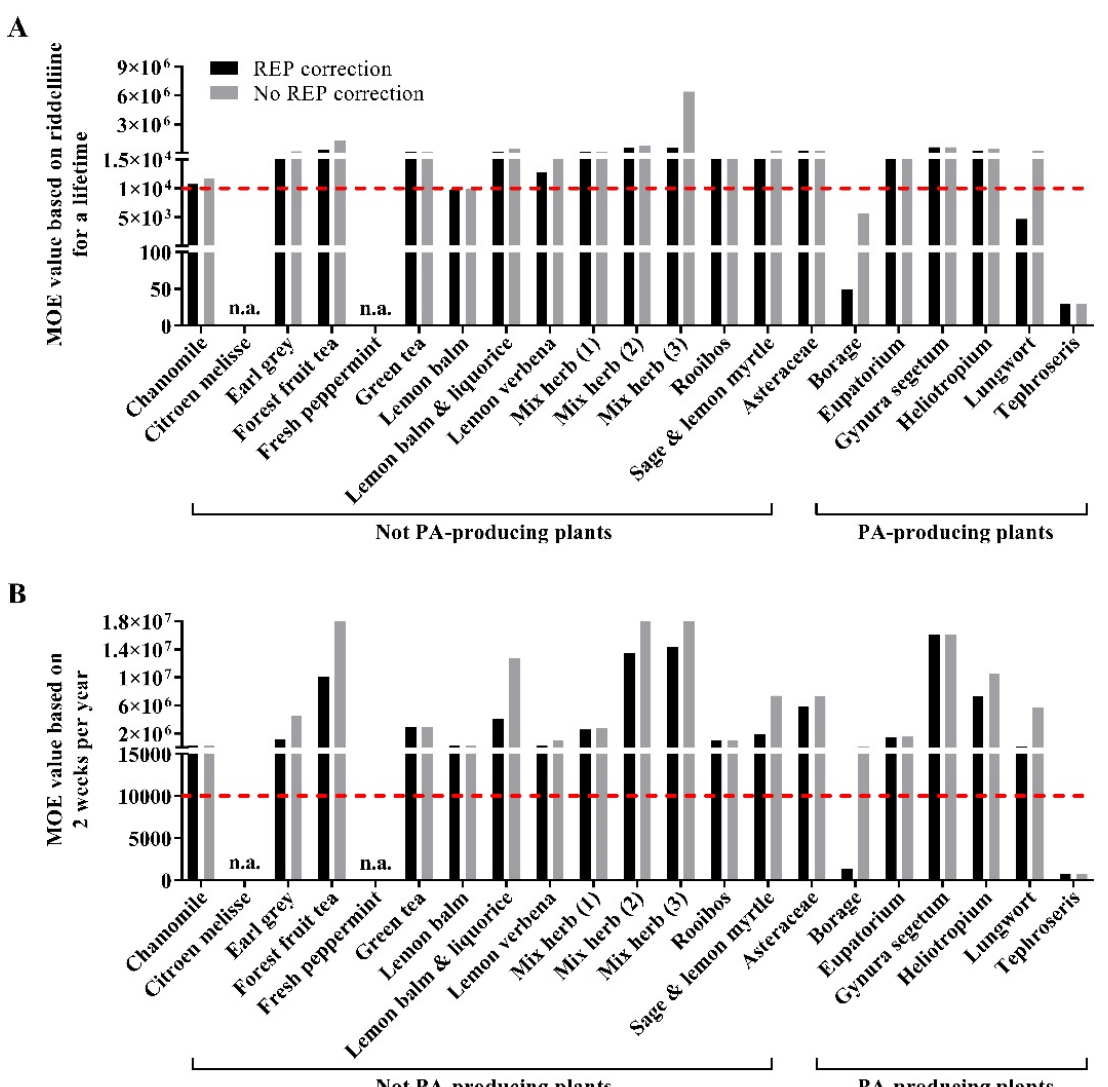
Figure 1. The MOE values calculated based on riddelliine for different types of (herbal) teas with or without REP correction when assuming a daily intake of one cup of tea per day for a lifetime ( A ) and for 2 weeks a year during a lifetime ( B ). Black bars represent the MOE values obtained based on the total PA levels corrected by the corresponding REP factors, while grey bars represent the MOE without REP correction. The red dashed line represents an MOE value of 10,000. n.a. indicates that data are not applicable due to a PA content < LOQ.